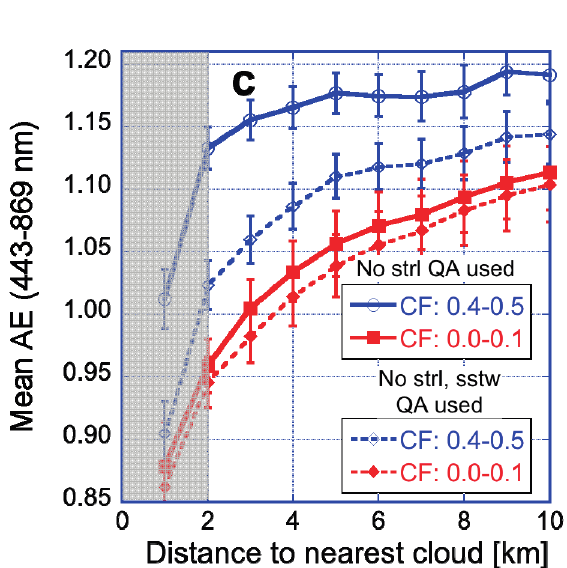
Figure 6. Same as Figure 3 (solid lines), but also showing the results (dashed lines) when the data selection ignores warnings by both the straylight (marked strl) and sstwarn (marked sstw) QA flags. ( a ) Number of pixels; ( b ) Aerosol optical thickness; ( c ) Angstrom